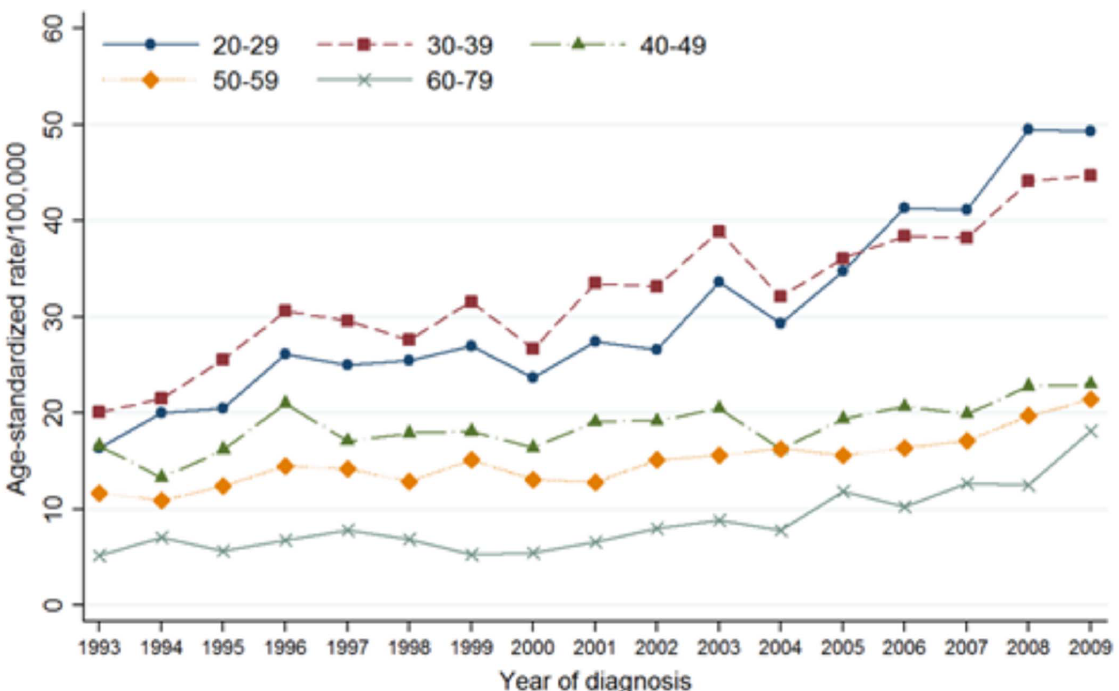
Figure 2. Trends in age standardized incidence rate for cervical carcinoma insitu according to the age group in Korea, 1993–2009. doi:10.1371/journal.pone.0072012.g002 PLOS ONE |